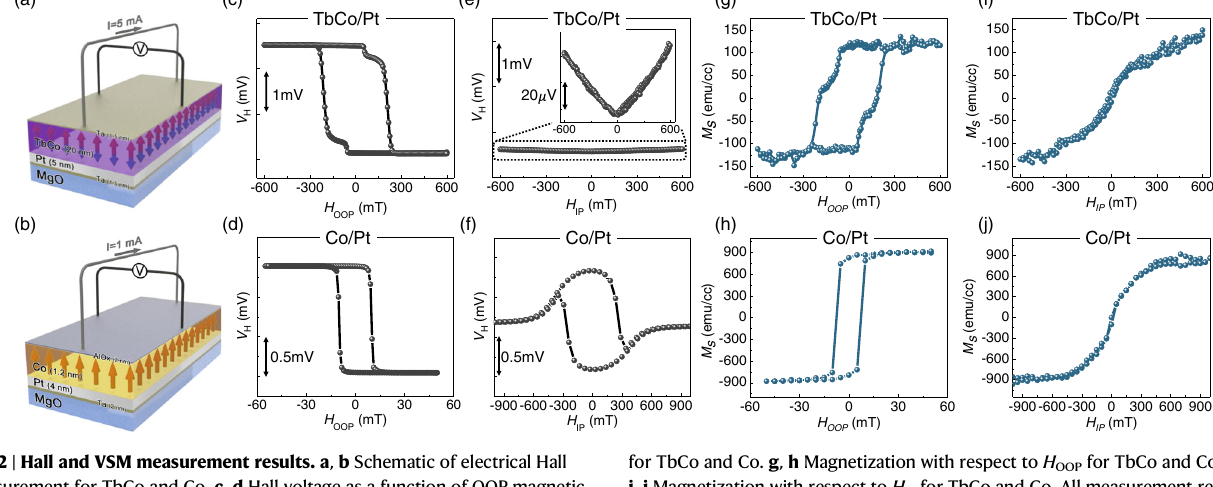
for TbCo and Co. g , h Magnetization with respect to H OOP for TbCo and Co. i , j Magnetization with respect to H IP for TbCo and Co. All measurement results fi eld, H were obtained at room temperature ( T =305K). IP ,